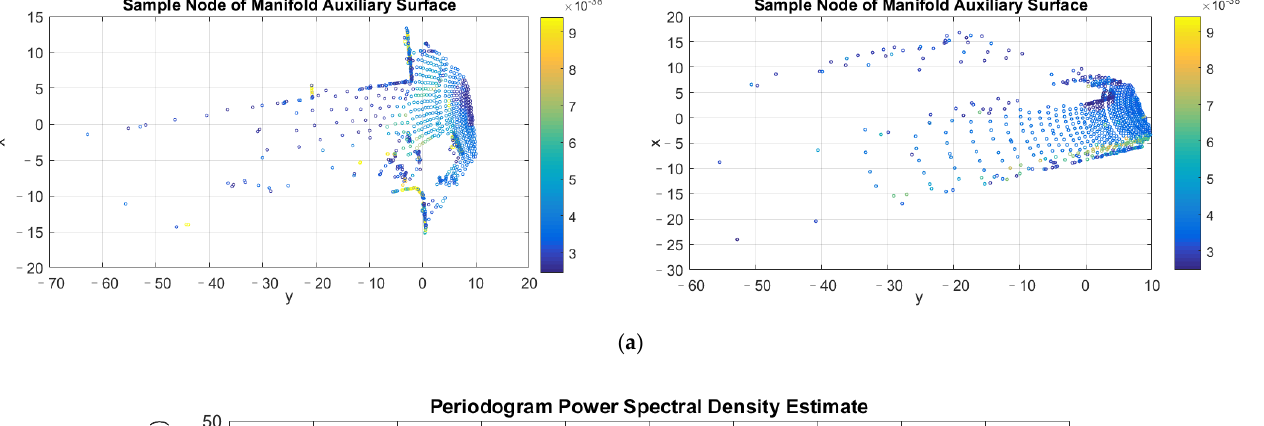
ISPRS Int. J. Geo-Inf. 2021 , 10 , x FOR PEER REVIEW